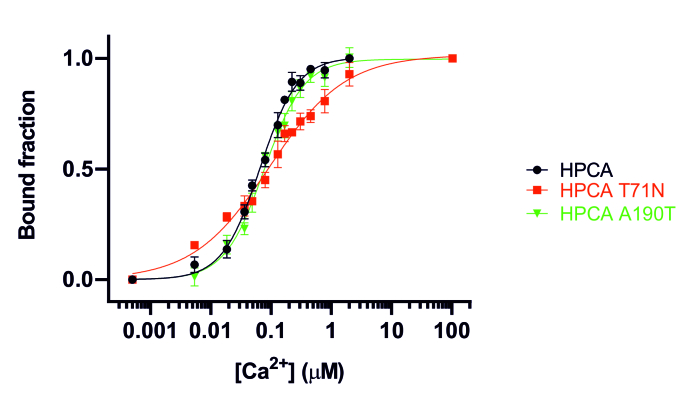
Equilibrium Ca2+-binding titrations for hippocalcin wild-type and mutants measured by intrinsic tryptophan fluorescence at 20 °C. Fluorescence changes (λex = 280 nm and λem = 340 nm) are normalised to F0 of 0 and Fmax of 1 and fitted to the Hill equation. Fitted curves are represented by solid lines overlaying the data points. Titrations were performed at least in triplicates and represented as mean ± SEM.